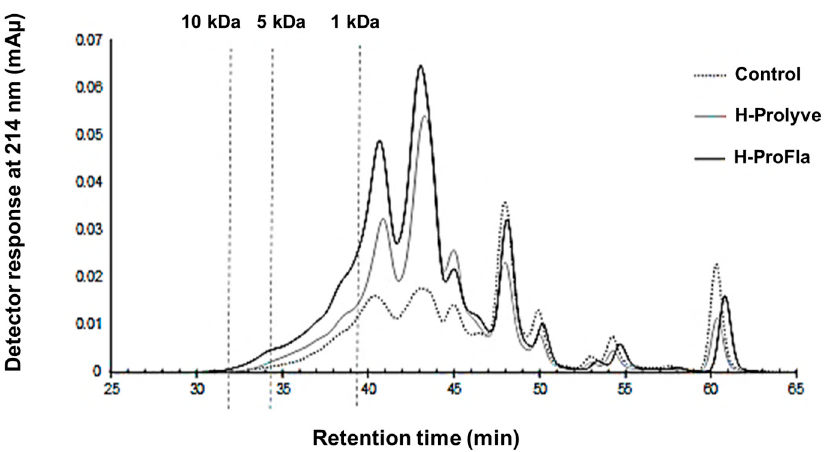
Figure 2. Gel permeation high-performance liquid chromatography profiles of P. dioica conchocelis following 2 h hydrolysis at 50 ◦ C with Prolyve (H-Prolyve) and a total of 4 h hydrolysis with Prolyve plus Flavourzyme (H-ProFla). Dashed vertical lines indicate the retention times corresponding to proteins and peptides with masses of 10, 5 and 1